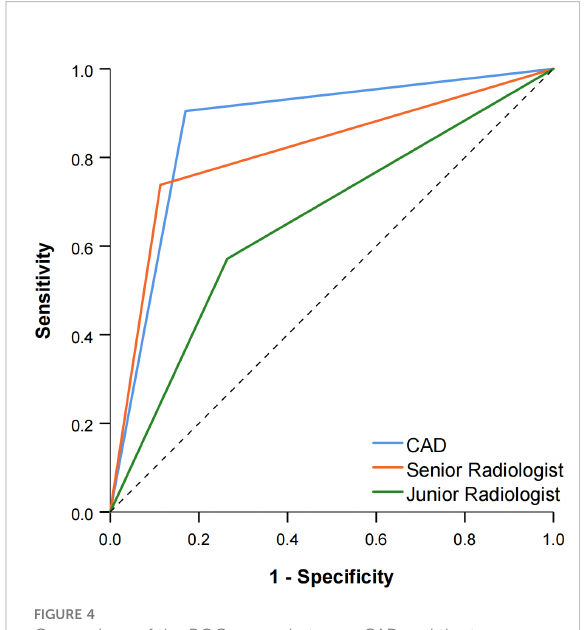
FIGURE 4 Comparison of the ROC curves between CAD and the two radiologists when TR5 was used as the cutoff